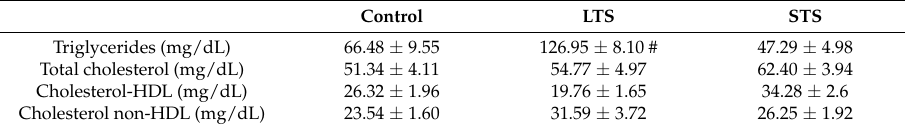
Table 2. The effects of long-term (LTS) and short- term (STS) administration of sucrose on serum triglycerides, total cholesterol (TC), high- density lipoprotein cholesterol (HDL-C), and non-HDL-C levels. Data represent mean ± SEM, # p < 0.01 after one-way ANOVA, n = 10 determinations from 10 different rats from each group.